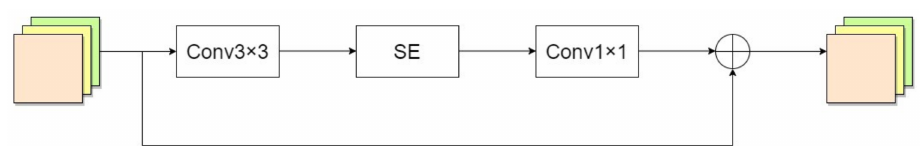
Figure 3. MBConv.